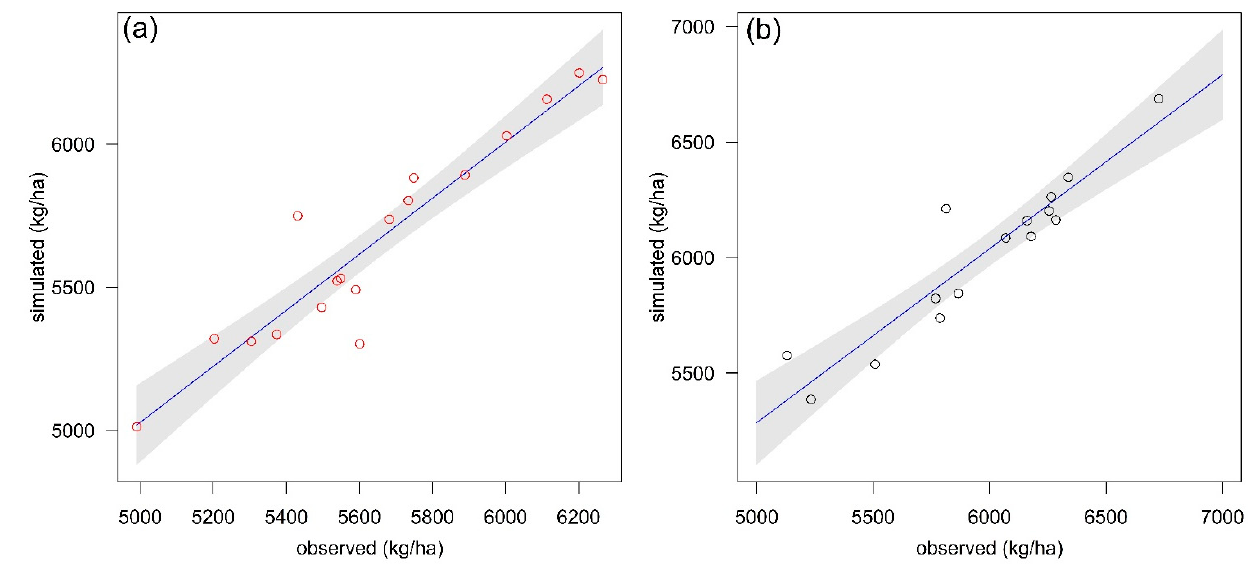
Table 3. DSSAT model performance for the Ciherang rice variety.